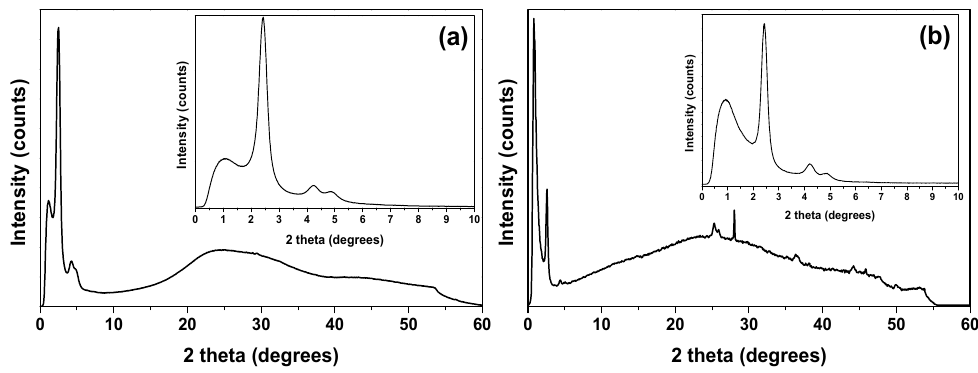
Figure 3. Wide- and low-angle XRD patterns of ( a ) CaBG and ( b ) SrBG BGs.